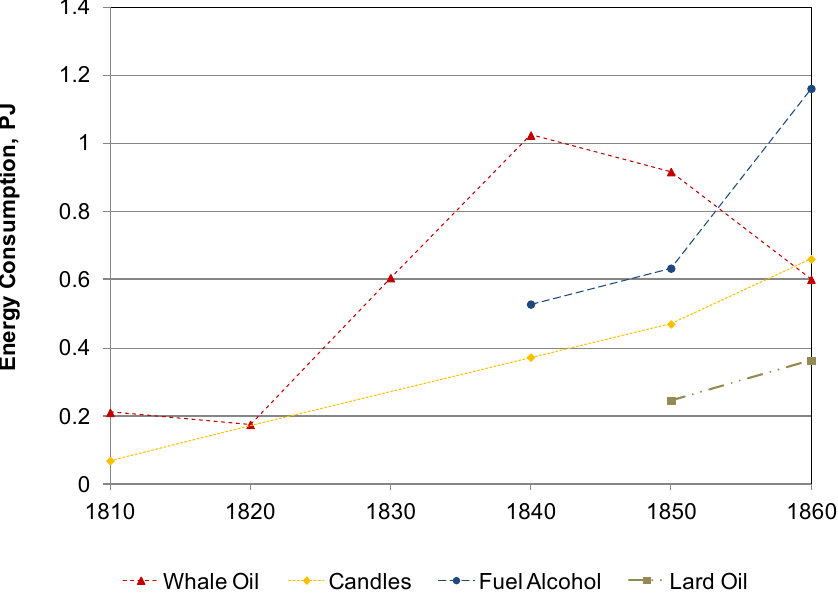
Figure 6. Consumption of other biomass fuels, 1810–1860. Sources: [13,27,42]. Candle quantity inferred from prices in